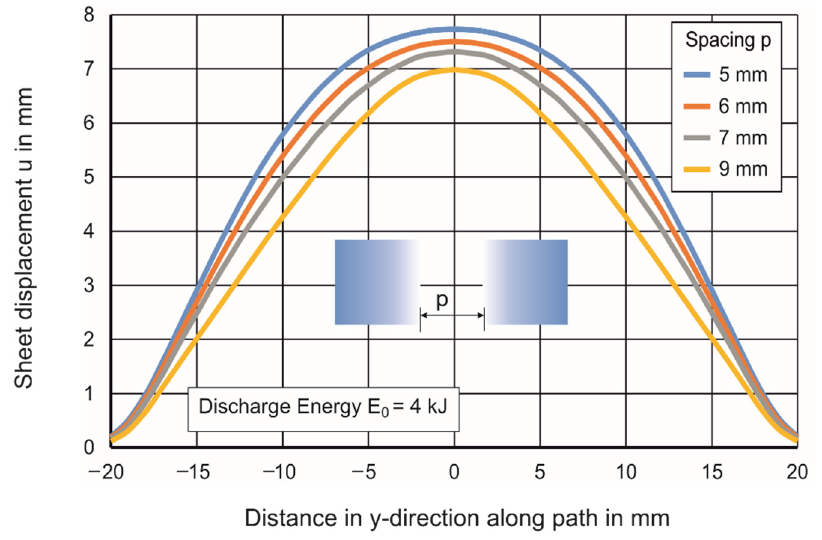
Figure 15. Experimentally measured displacement of the workpiece in z-direction along path 2.